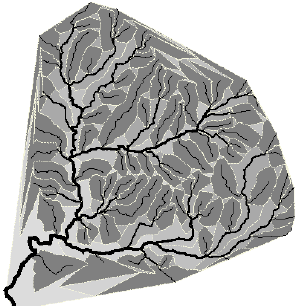
Figure 4. An example of hierarchical partitioning of river catchments.